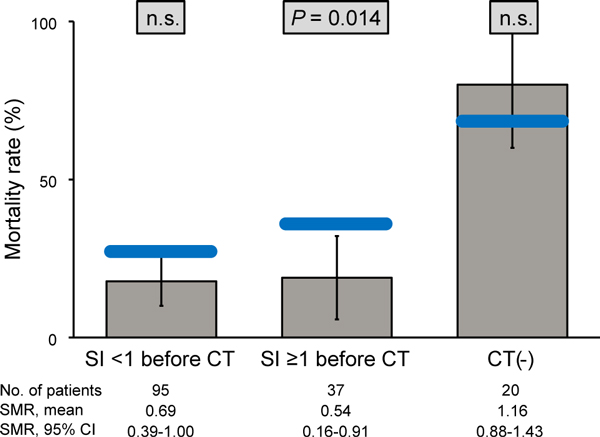
Outcome analysis for calculation of standardized mortality ratio (SMR) on the basis of shock index (SI) value. The patients who underwent CT scanning were divided into two groups on the basis of their SI value. The gray columns represent observed mortality rates, the blue bars represent predicted mortality rates, and the whisker bars represent the 95% confidence range.